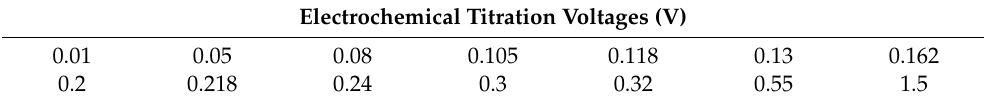
Table 2. The electrochemical titration voltages of cells prepared for LIBS calibration. Electrochemical Titration Voltages